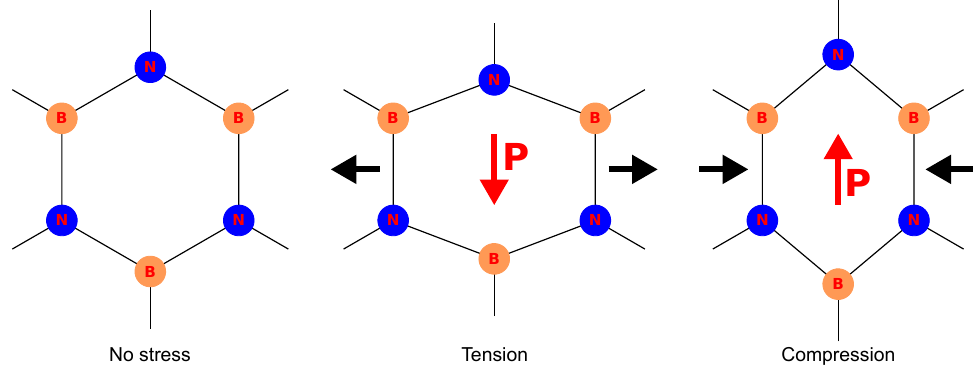
Figure 5. Pristine Hexagonal Boron-Nitride unit-cell and under deformation. The deformation of the cell, tension or compression, provokes a change in